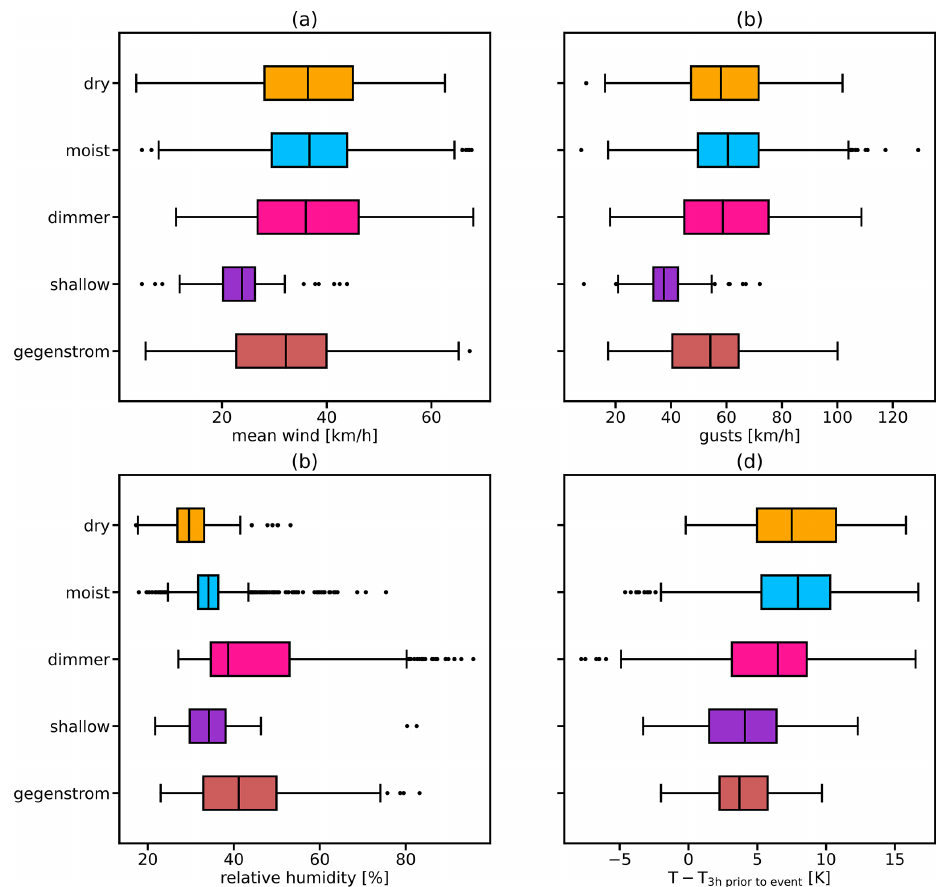
Figure 12. Boxplots of Altdorf station measurements of (a) mean wind speed, (b) wind gusts, (c) relative humidity and (d) the temperature difference for the different foehn